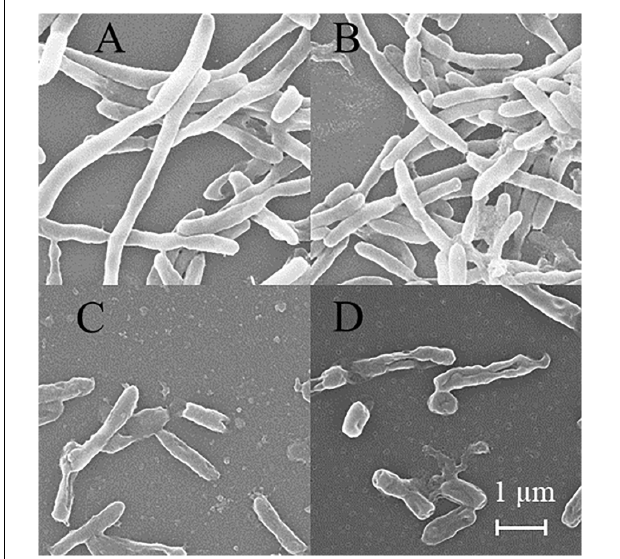
FIGURE 6 | SEM of MTB treated by 8.0 µ g/ml DHA-CS NPs for 6 d ( n = 3). (A) Negative control group, (B) 8.0 µ g/ml free DHA drug group, (C) 8.0 µ